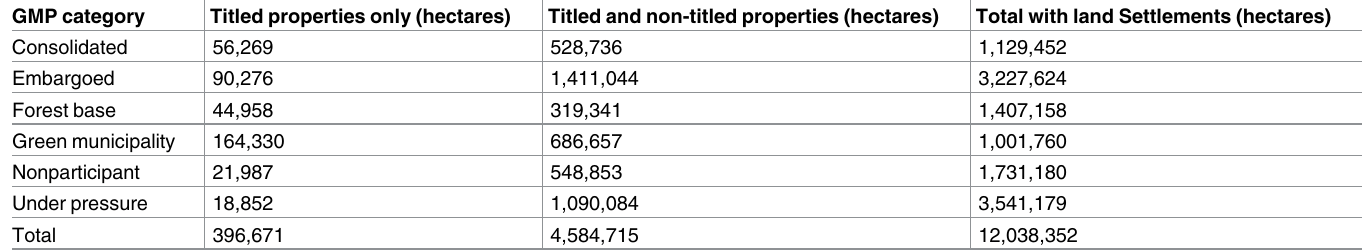
Table 5. Estimated forest surplus by tenure status and Green Municipality Program